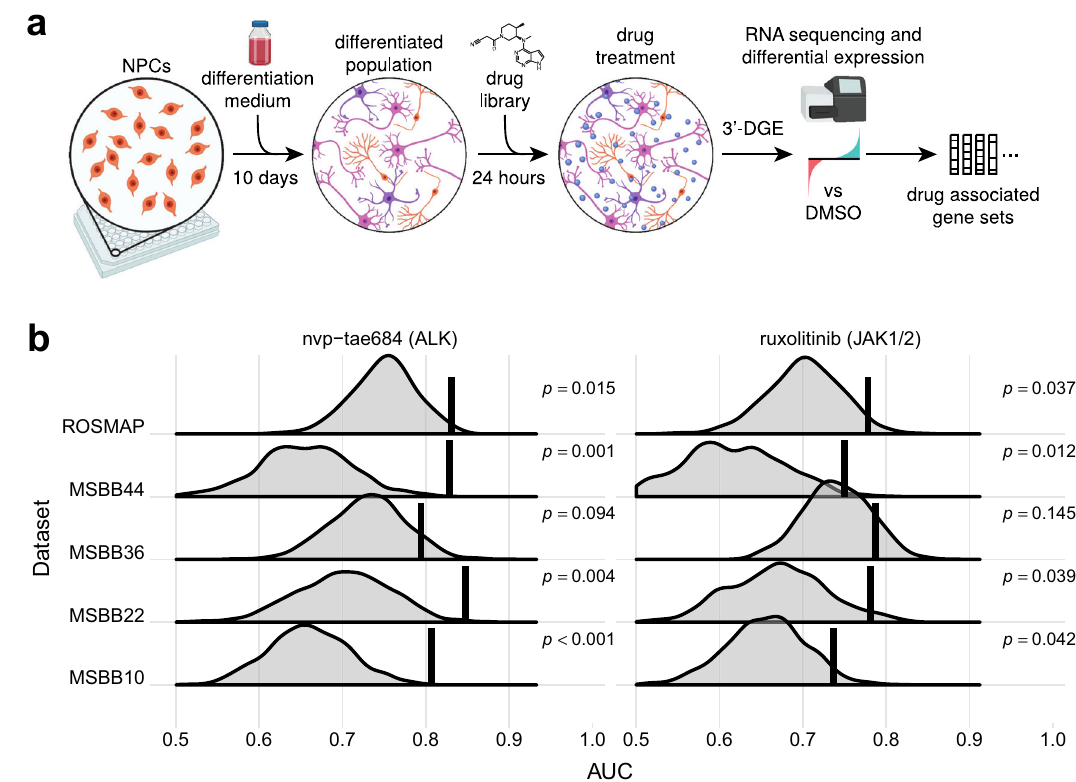
Fig. 2 Collection and evaluation of drug-associated gene lists. a Overview of the 3 ′ DGE experimental protocol used to derive drug-associated gene expression signatures. ReNcell VM human neural progenitor cells were plated and differentiated for 10 days, resulting in a mixed cell population of neurons, glia, and oligodendrocytes. The mixed culture was subsequently treated with a panel of drugs (Supplementary Data 3) at 10 µ M for 24 h and frozen in a lysis buffer until library preparation. RNA was extracted and reverse transcribed into cDNA in each well of the plate, followed by pooling and preparation of mRNA libraries. After sequencing, mRNA reads were demultiplexed according to well barcodes, and the resulting gene expression pro fi les were processed by a standard differential expression method to derive drug-associated gene lists. b A highlight of two compounds whose gene lists consistently yield improved performance over the randomly selected lists of equal length. Shown is performance associated with predicting early-vs-late disease stages in several AMP-AD datasets. Each row corresponds to an evaluation of gene lists in a single dataset; MSBB evaluation is subdivided into four brain regions, speci fi ed as Brodmann Area. The vertical line denotes performance of the drug-associated list, while the background distribution shows performance of gene lists randomly selected from the same dataset. The drugs are annotated with their nominal targets. The unadjusted p -values were computed with a one-sided empirical test, by counting the fraction of randomly selected lists that outperformed the corresponding drug-associated 3 ʹ Digital Gene Expression pro fi les drug-induced perturbation of mRNA expression . Drug responses were generated using the RenCell VM human neural progenitor cell line. Upon growth factor withdrawal, RenCell VM cells differentiate into a mixed